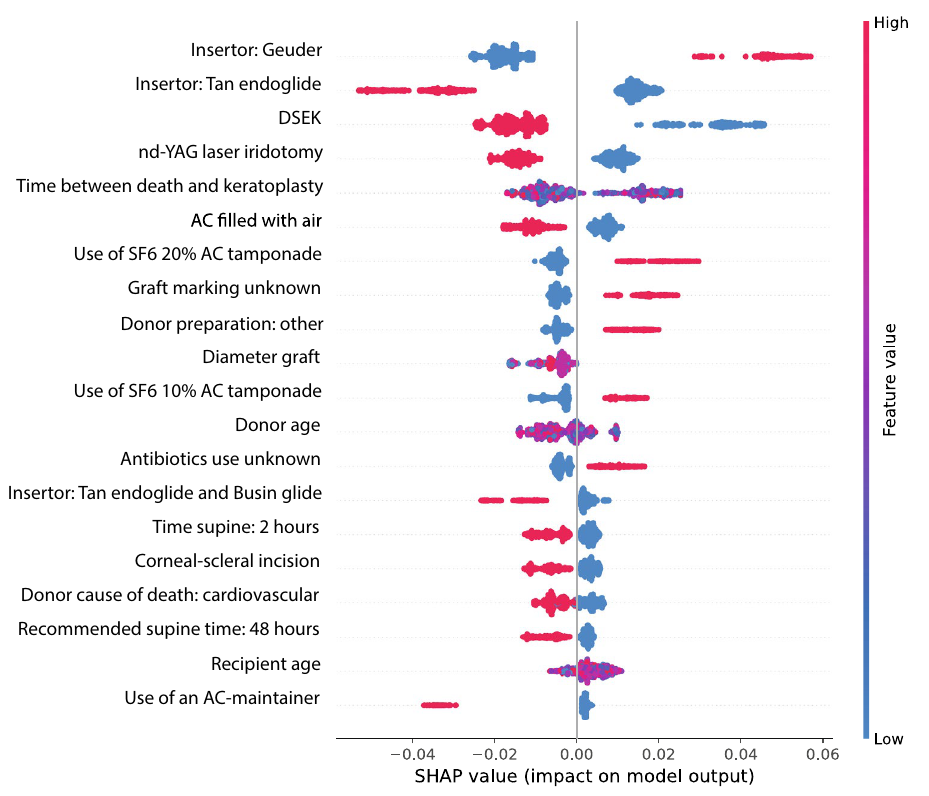
Figure 1. Summary of the SHAP values based on the random forest classifier model. The y-axis shows the most relevant features for predicting graft detachment, from highest to lowest. The x-axis displays the SHAP values, reflecting the effect of each variable on the model’s outcome by indicating the predicted change in the probability of a graft detachment. A negative SHAP value represents a “protective effect” (i.e., decreased risk of detachment), while a positive SHAP value represents a “risk effect” (i.e., increased risk of detachment). Each symbol in the plot represents an individual patient in the test dataset. The color gradient ranging from blue to red represents the range of values of the variables. For binary variables, only two colors are used (red for “yes” and blue for "no"); for continuous variables, the values are depicted using the entire spectrum from red to